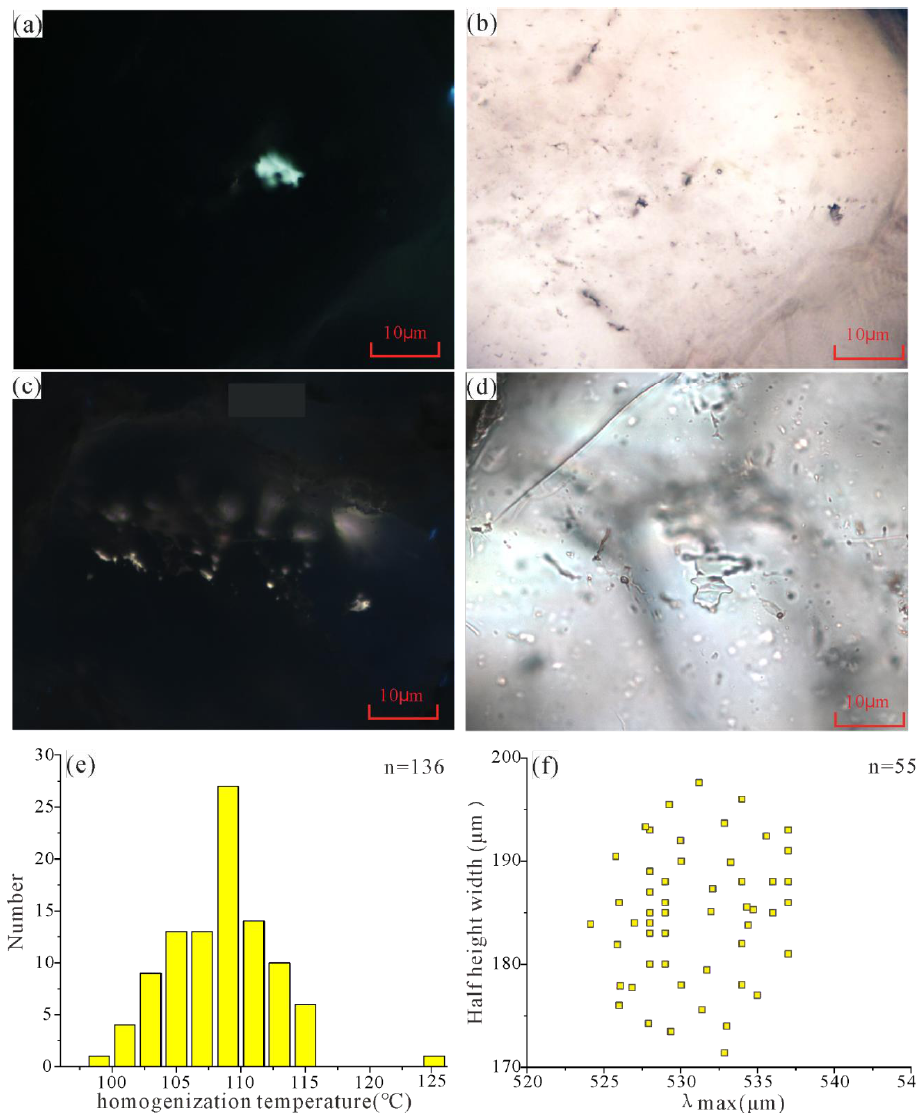
Figure 10. Micrographs of oil inclusions of the sandstone reservoirs in the Toutunhe Formation. Yellow fluorescent oil inclusions trapped in a quartz crack, ( a ) transmission light and ( b ) fluorescent light, 3709.4 m, Y1 well; yellow fluorescent oil inclusions trapped in healed microfractures developed in a detrital quartz grain, ( c ) transmission light and ( d ) fluorescent light, 3642.2 m, Y1 well; histogram of homogenization temperatures of aqueous inclusions corresponding to oil inclusions in the same oil-aqueous inclusion pairs ( e ); Scatter of half height width and λ max of fluorescence in oil inclusion ( f ).